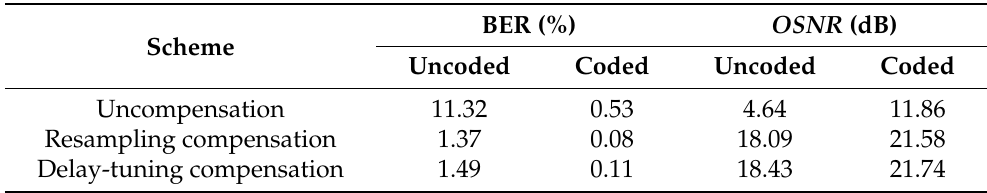
Table 4. BER and OSNR under different communication schemes with LMS equalizer at uncoded and coded conditions for lake experiment.